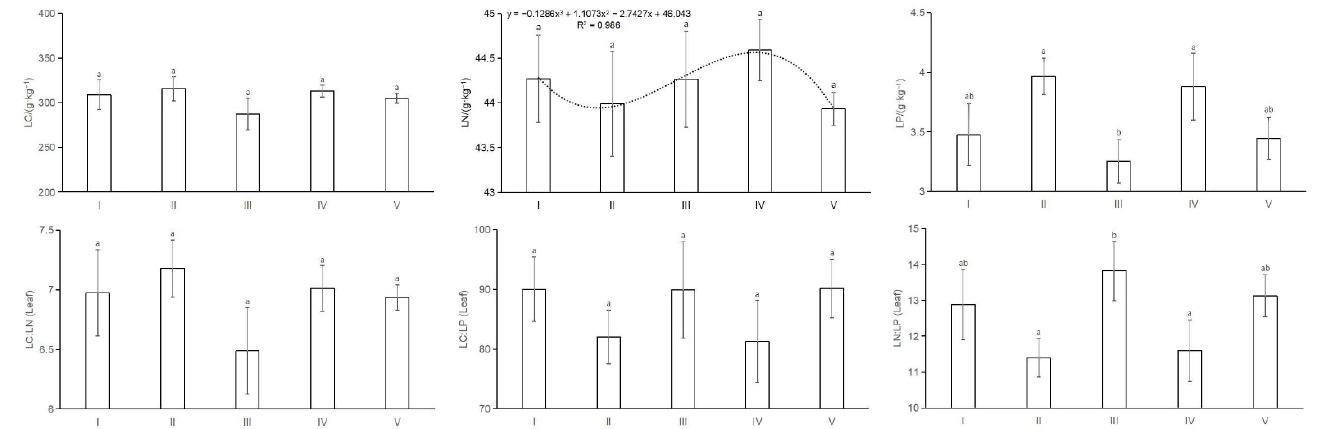
Figure 2. LC, LN, and LP contents and stoichiometric characteristics changes of Moso bamboo ( Phyllostachys edulis (Carriere) J. Houzeau) when expanding into Chinese fir ( Cunninghamia lanceolata (Lamb.) Hook.) forests (LC: leaf carbon; LN: leaf nitrogen; LP: leaf phosphorus; I–V represent different expansion stages of Moso bamboo and different lowercase letters indicate significant differences between I ‐ V stages, the same as follows).